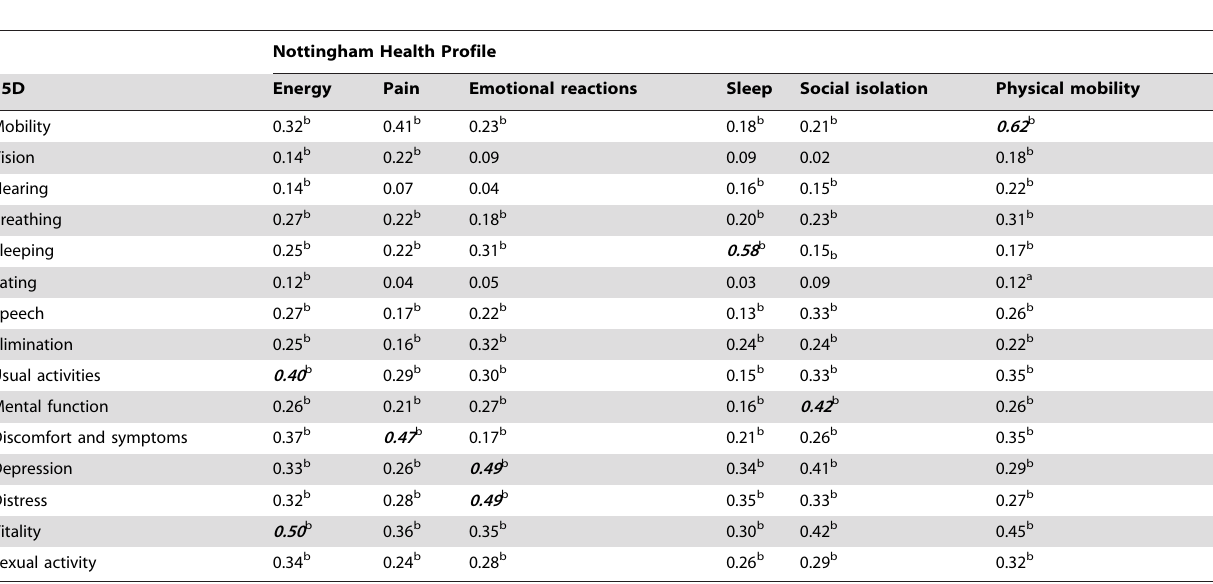
Table 4. Spearman’s rank correlation coefficients between the 15D and Nottingham Health Profile